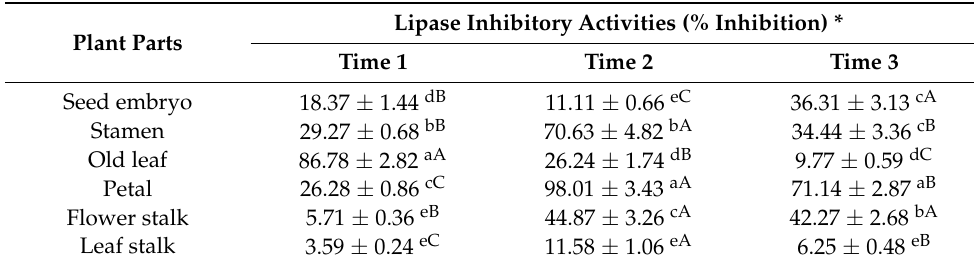
Table 9. Lipase inhibitory activities of different sacred lotus parts collected from different time periods. Plant Parts